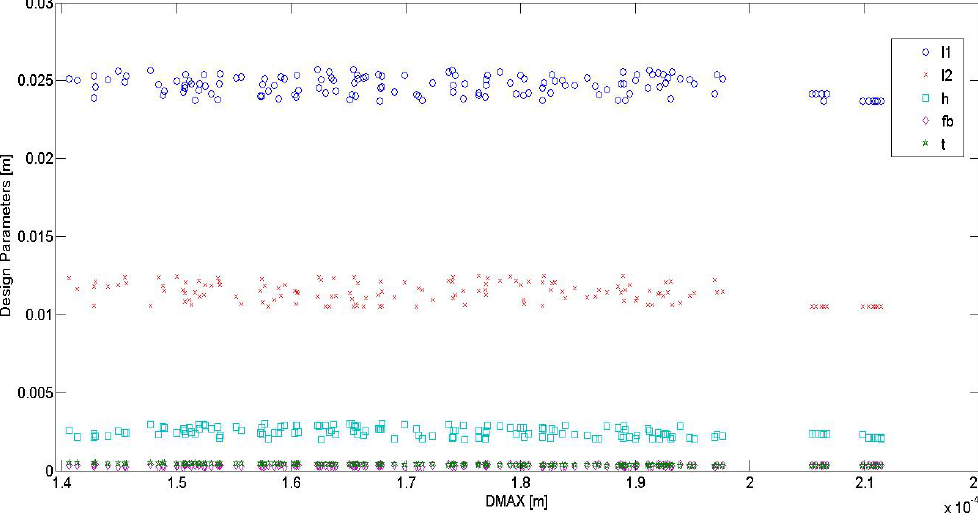
Table 6: Optimized Dynamic and Static Analysis Results